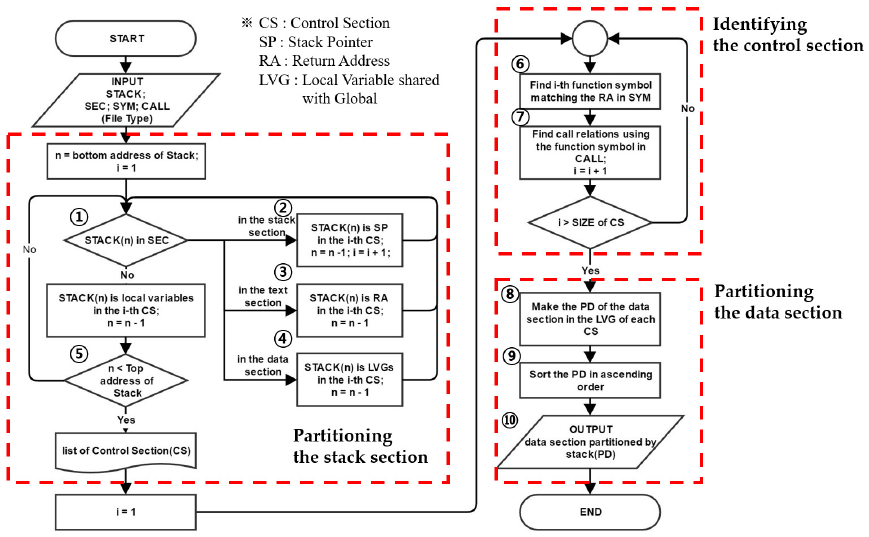
Figure 8. Flowchart of partitioning the data section using the stack.